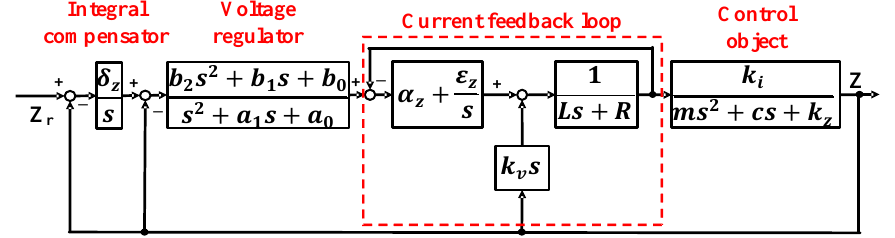
Figure 10. Controller Designed.